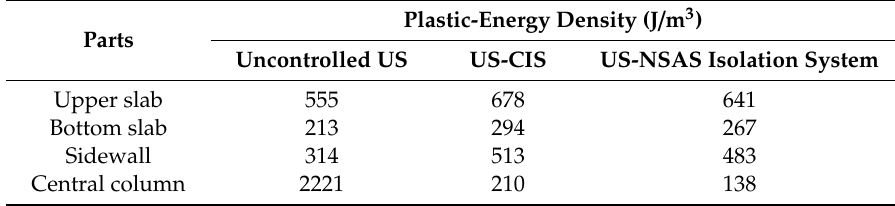
( c ) Figure 16. Histogram of energy proportions for ( a ) uncontrolled US, ( b ) US-CIS and ( c ) US-NSAS isolation system.